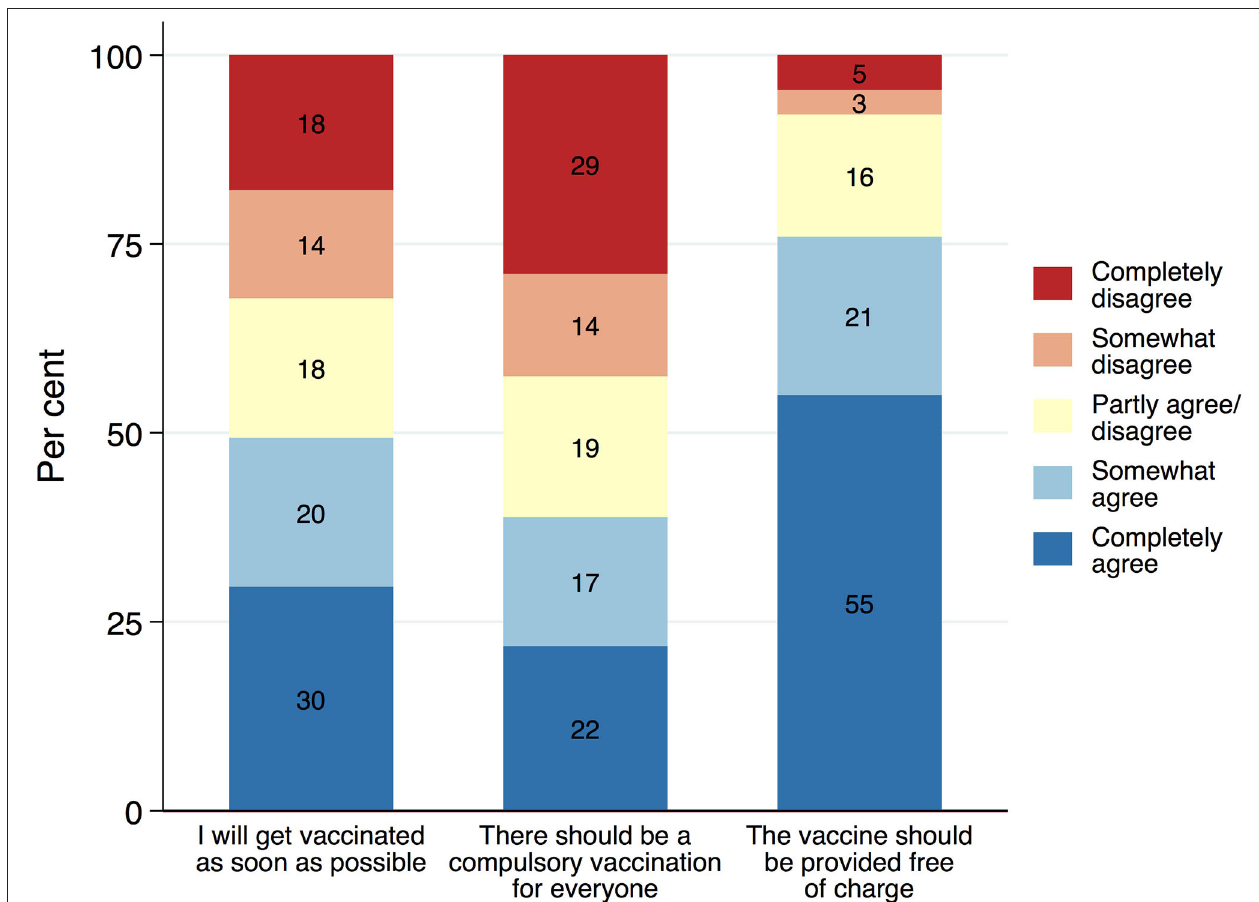
FIGURE 1 | Attitudes toward a COVID-19 vaccination. ACPP data ( N = 1,301; 23–27 May 2020;